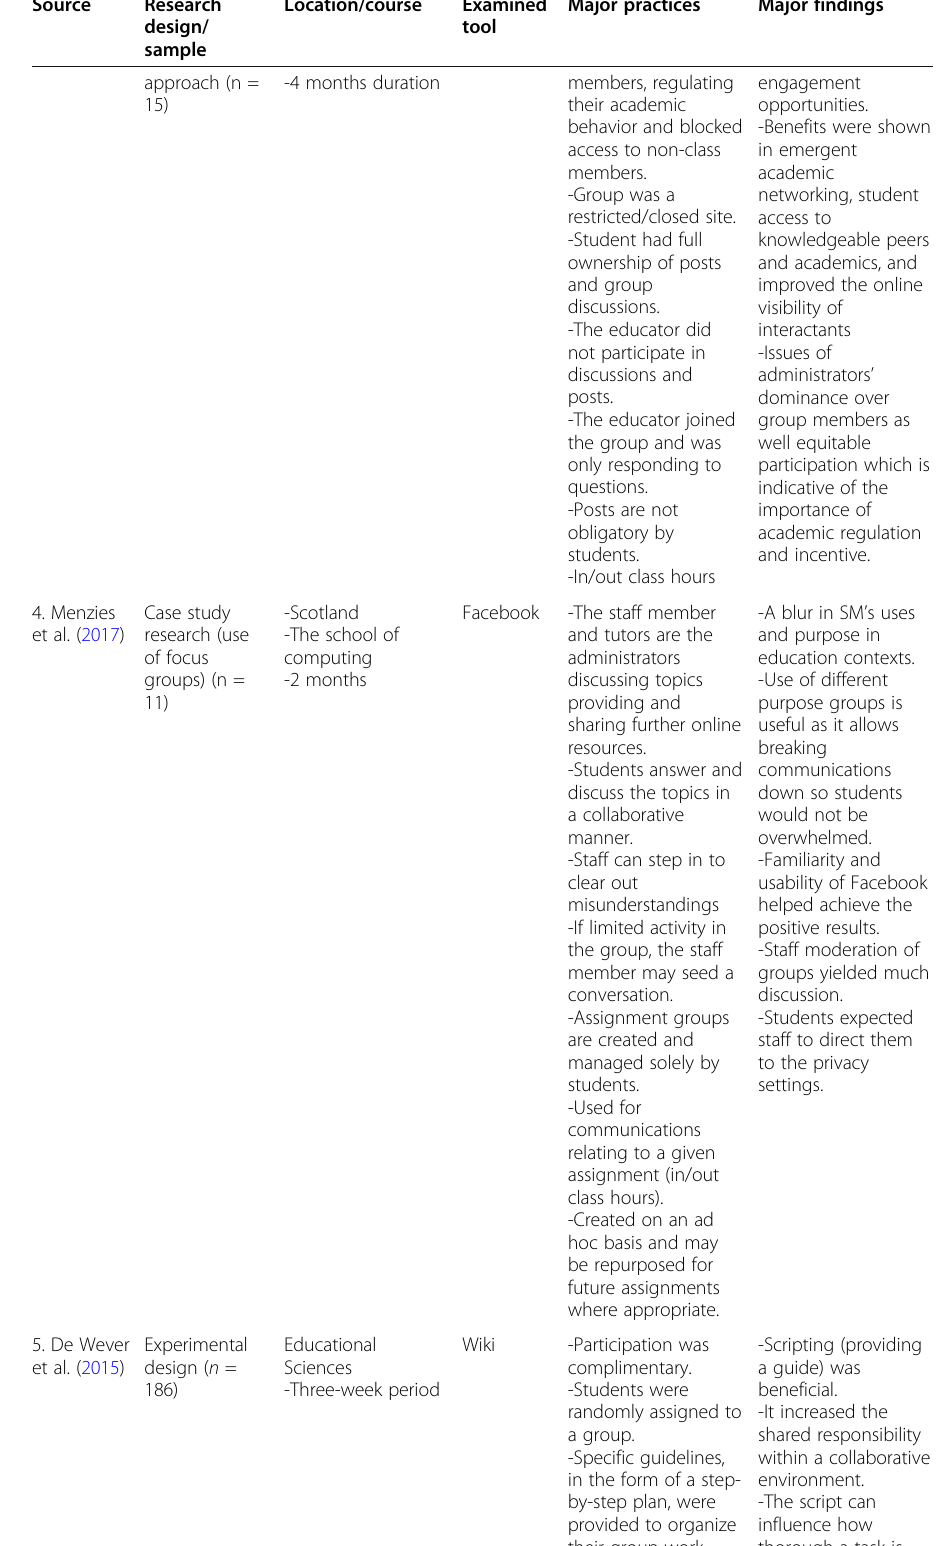
Table 4 The analysis of sources included in the integrative review